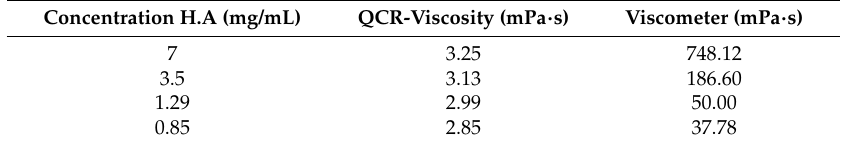
Table 4. Apparent viscosity obtained with the QCR biosensor and Fungilab viscometer.